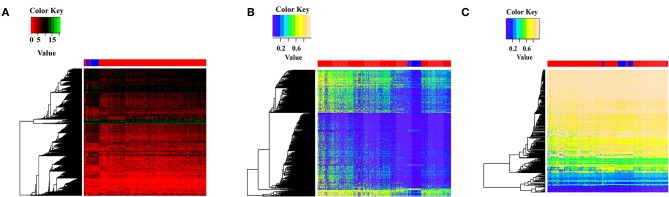
Feature display of target genes and circRNAs that interact with differentially expressed miRNAs. (A) The target genes expression of differential expression miRNAs between breast cancer samples and normal samples. Gene expression values were log2 transformed after adding a pseudo-value of 1 to avoid infinite values. Red indicates breast cancer samples, blue indicates normal samples. (B) DNA methylation cluster analysis of target genes bound by differentially expressed miRNAs. Red represents breast cancer samples, blue represents normal samples. (C) DNA methylation cluster analysis of circRNA host genes that interact with differentially expressed miRNAs. Red indicates breast cancer samples, and blue indicates normal samples.